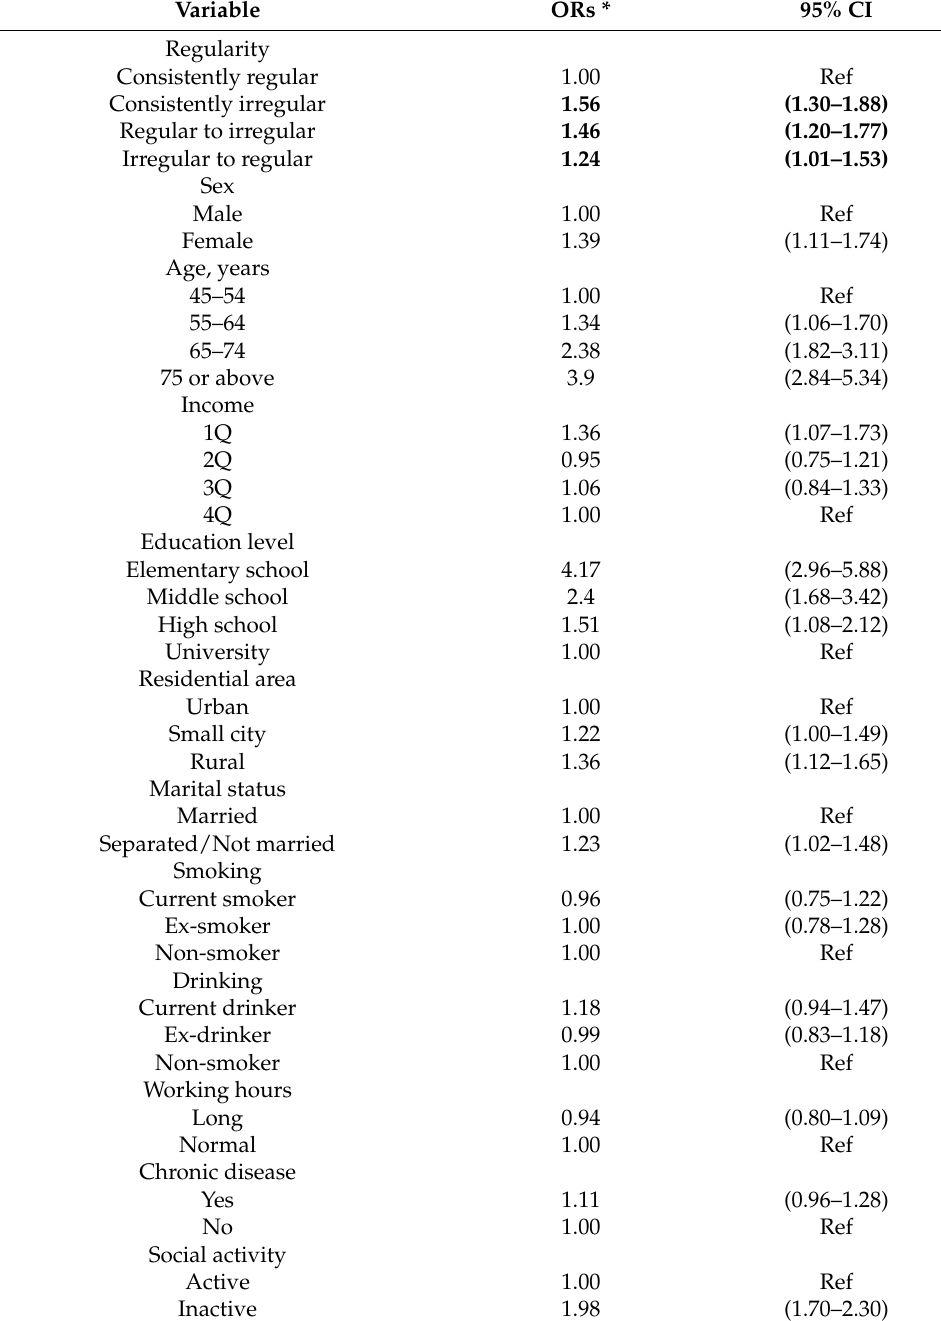
Table 2. Results of the generalized estimating equation model on cognitive